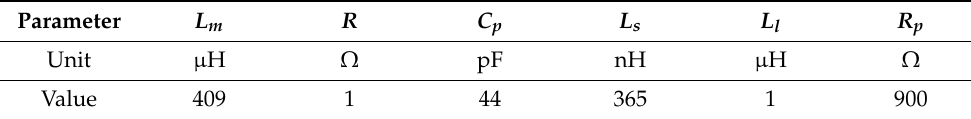
Table 1. Default parameters for frequency